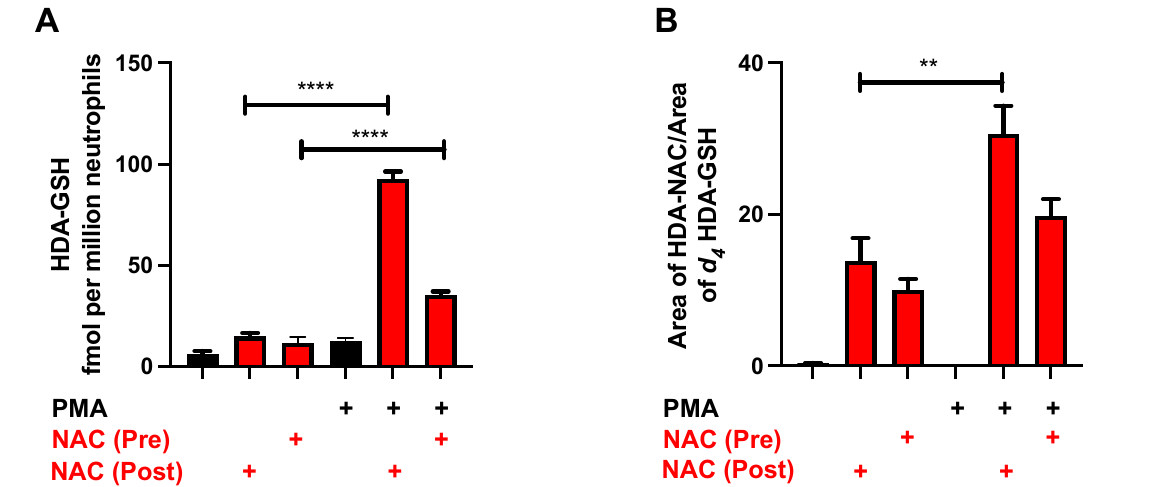
Figure 8 . HDA–NAC adduct formation in human neutrophils treated with NAC. In total, 2 × 10 6 neutrophils were pretreated (Pre) with 12 mM NAC for 30 min as indicated before activation with 200 nM PMA as indicated. In separate experiments, 12 mM NAC was added to neutrophils as indi- cated 25 min after PMA activation (Post). HDA–GSH ( A ) and HDA–NAC ( B ) were measured as described in “Materials and Methods”. n = 3 for each treatment from independent experiments. ** and **** indicate p < 0.01 and p < 0.0001 for indicated comparisons determined by ANOVA with Tukey’s post-hoc test.